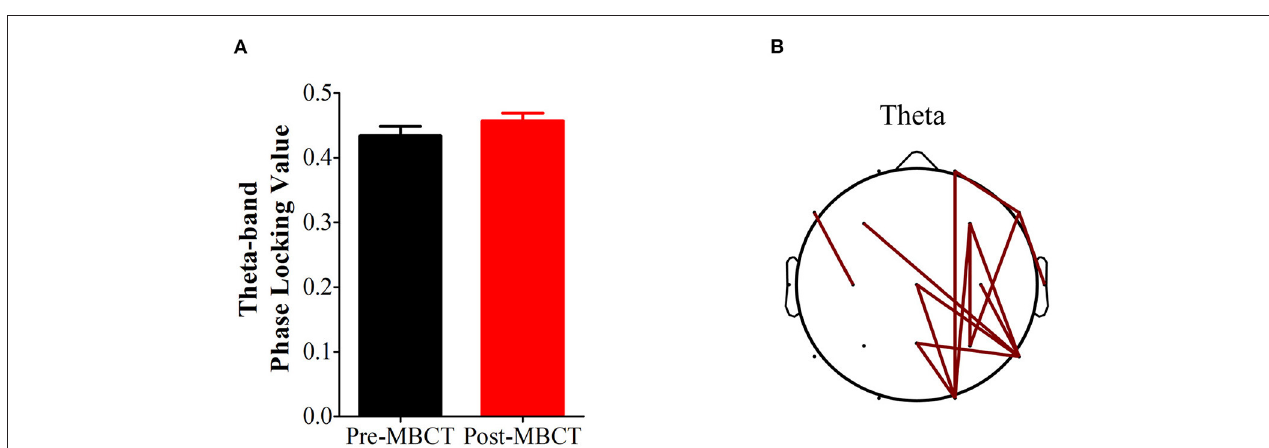
FIGURE 2 | Changes in theta-band phase synchronization after the 8-week MBCT intervention. (A) Bar plot of theta-band phase synchronization after MBCT compared with that before MBCT; P = 0.0755. Bars and vertical lines indicate mean and standard errors, respectively. (B) Topological comparison of theta-band phase locking value after MBCT intervention. Each edge represents a significantly reduced theta-band phase locking value after the intervention based on a P -value of 0.05 (FDR corrected).